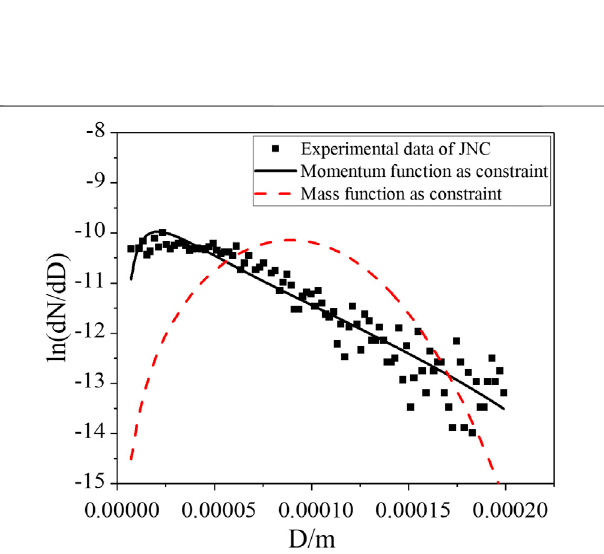
FIGURE 5 | Results of diesel droplet size distribution under the pressure difference of 9.8 MPa.